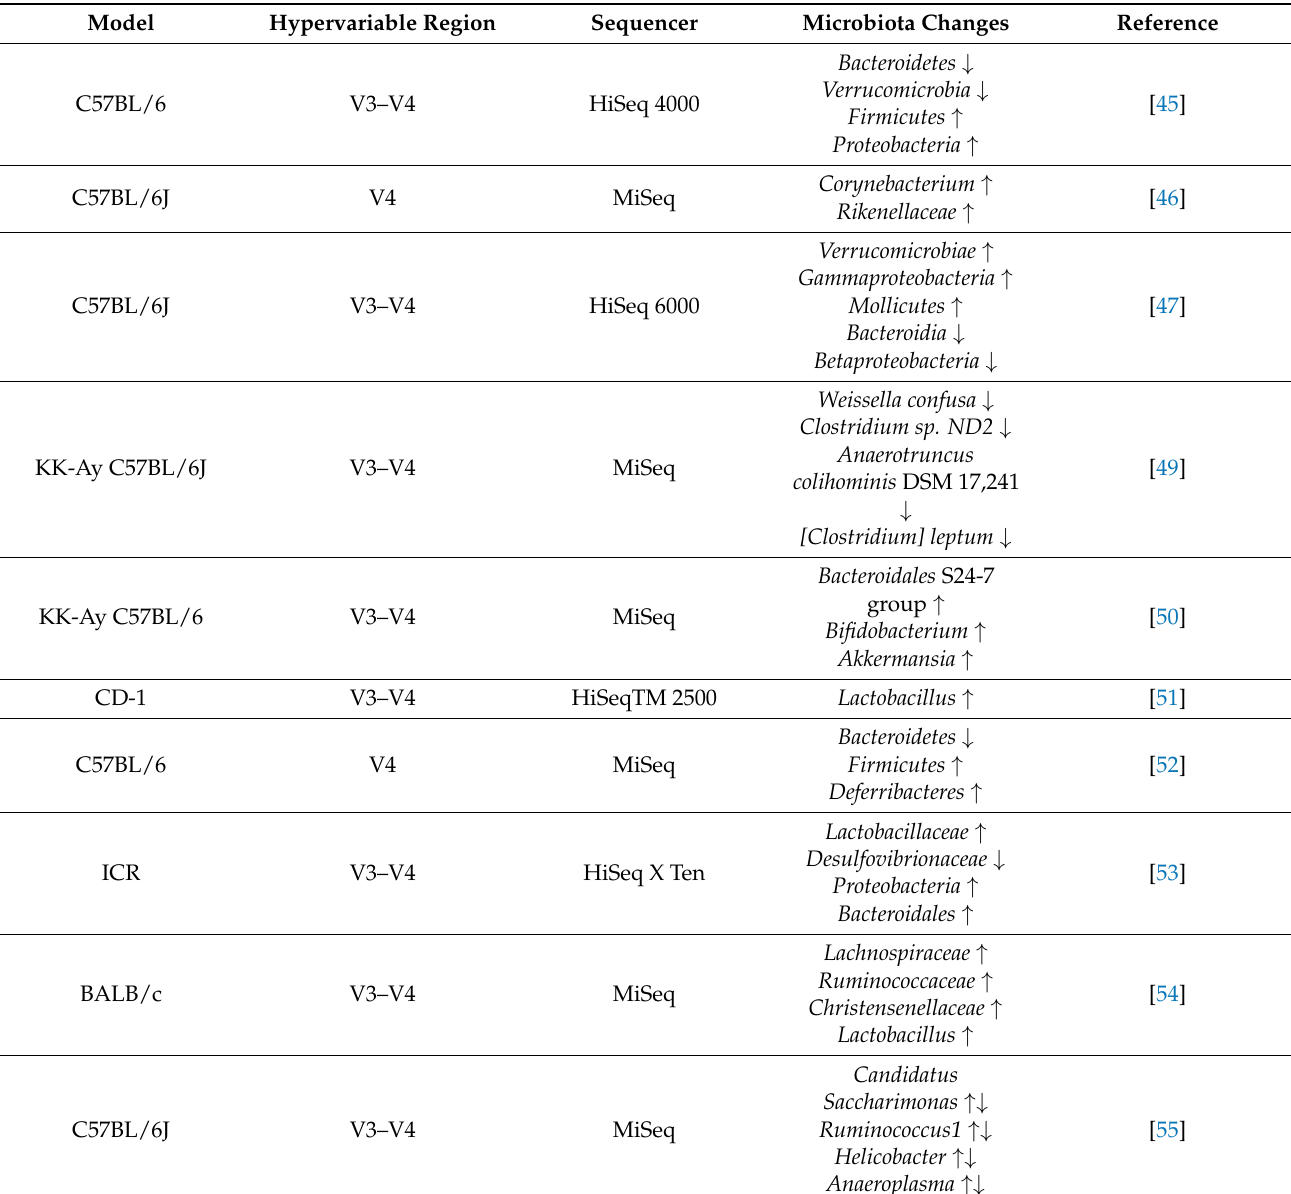
Table 4. Summarization of the studies in which the authors sequenced the 16S rRNA in